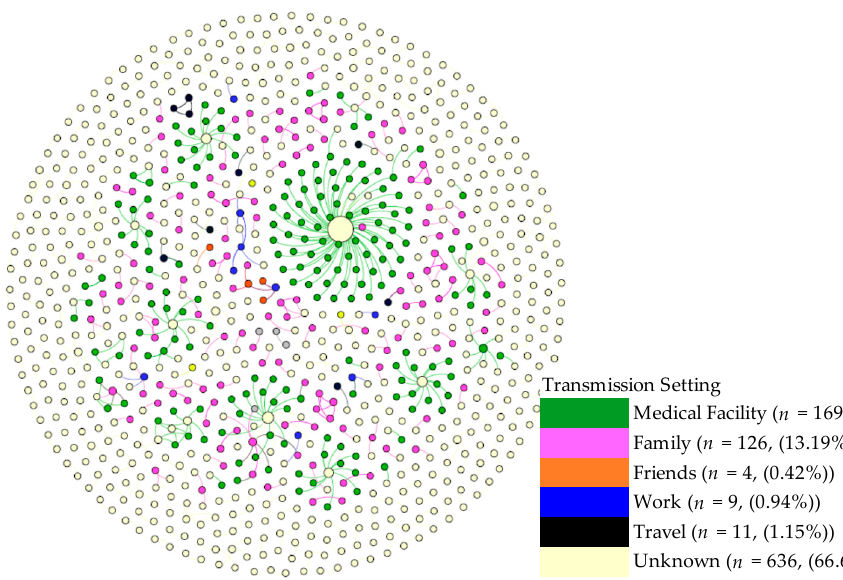
Figure 5. Symptomatic/Asymptomatic Status in Viral Transmission Networks (Hokkaido and Kanagawa). The homophily of asymptomatic and symptomatic cases is shown. Most asymptomatic COVID-19 patients cause downstream infections that are also asymptomatic. Circle size denotes impact (number of infectees).